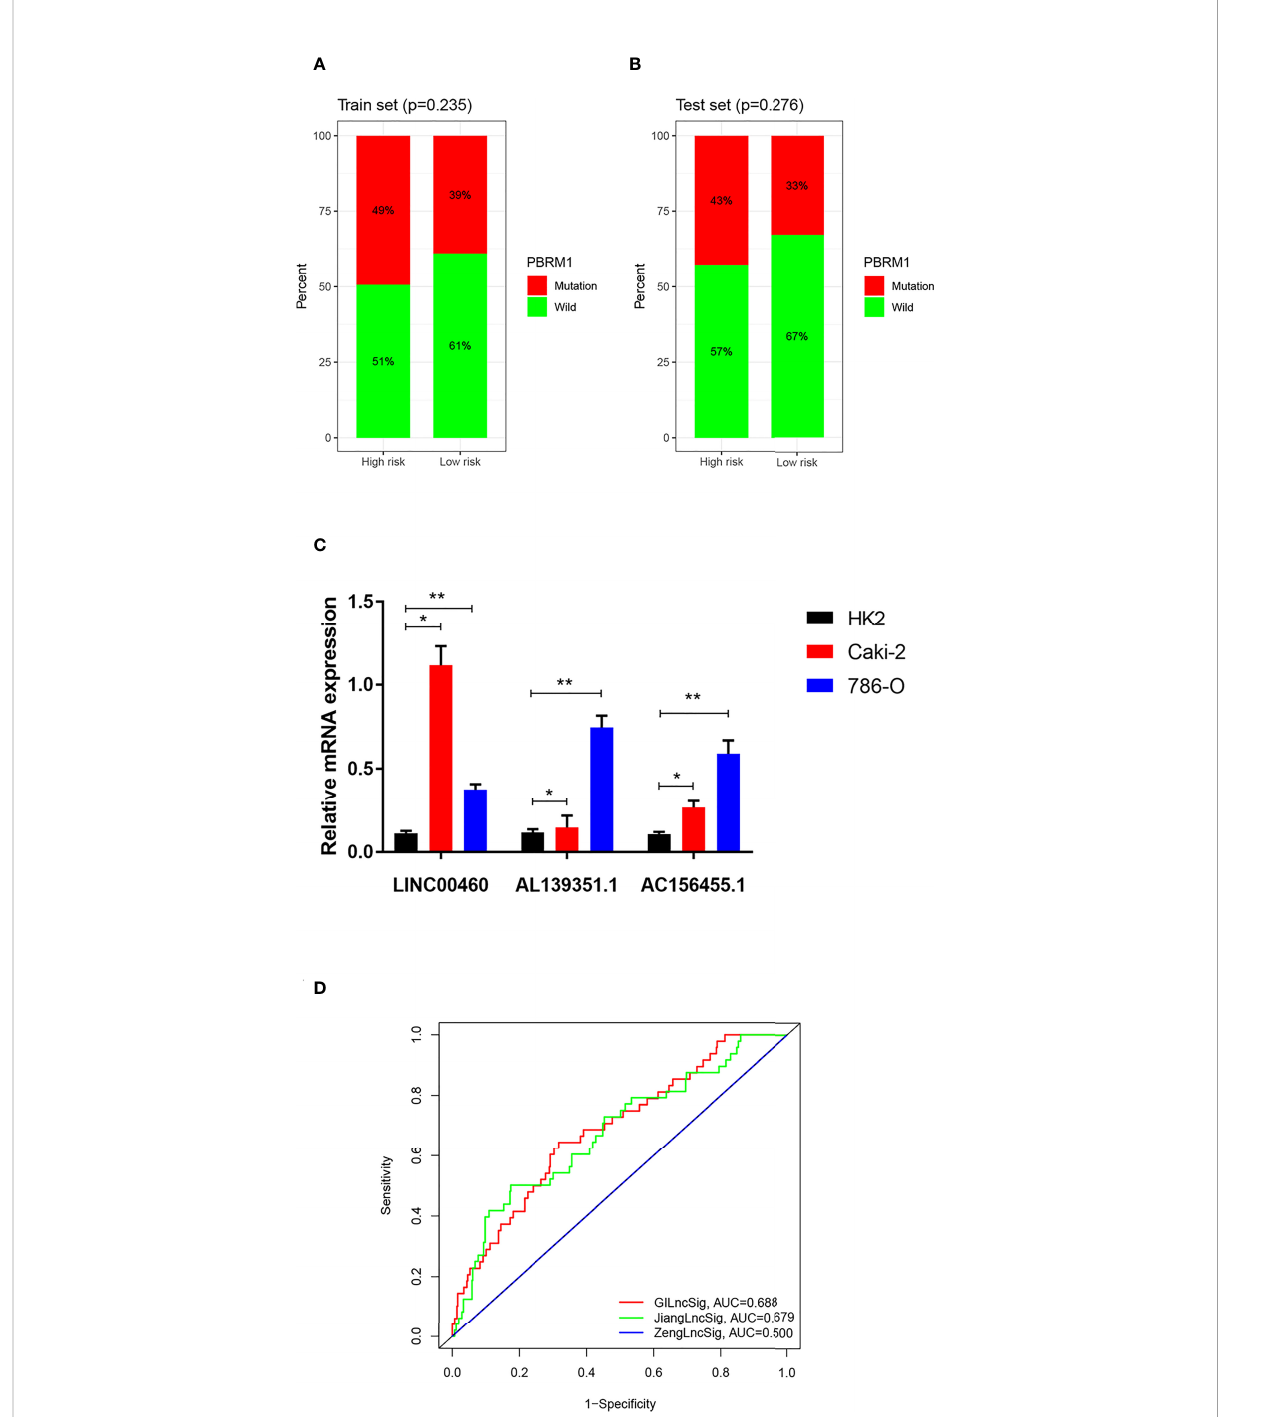
FIGURE 7 (A, B) Carcinogenic function analysis of GILncSig based on single geng mutation of PBRM1: Proportional bar plots of mutation type and wild type of PBRM1 in samples of training set and testing set. (C) mRNA expression of LINC00460, AL139351.1 and AC156455.1 in HK2, 786-O and Caki-2 cells according to qRT-PCR analysis. (D) Comparison among three lncRNA-based prognostic models based on AUCs: ROCs of GILncSig, SunLncSig and ZengLncSig. * means p<0.05, and ** means